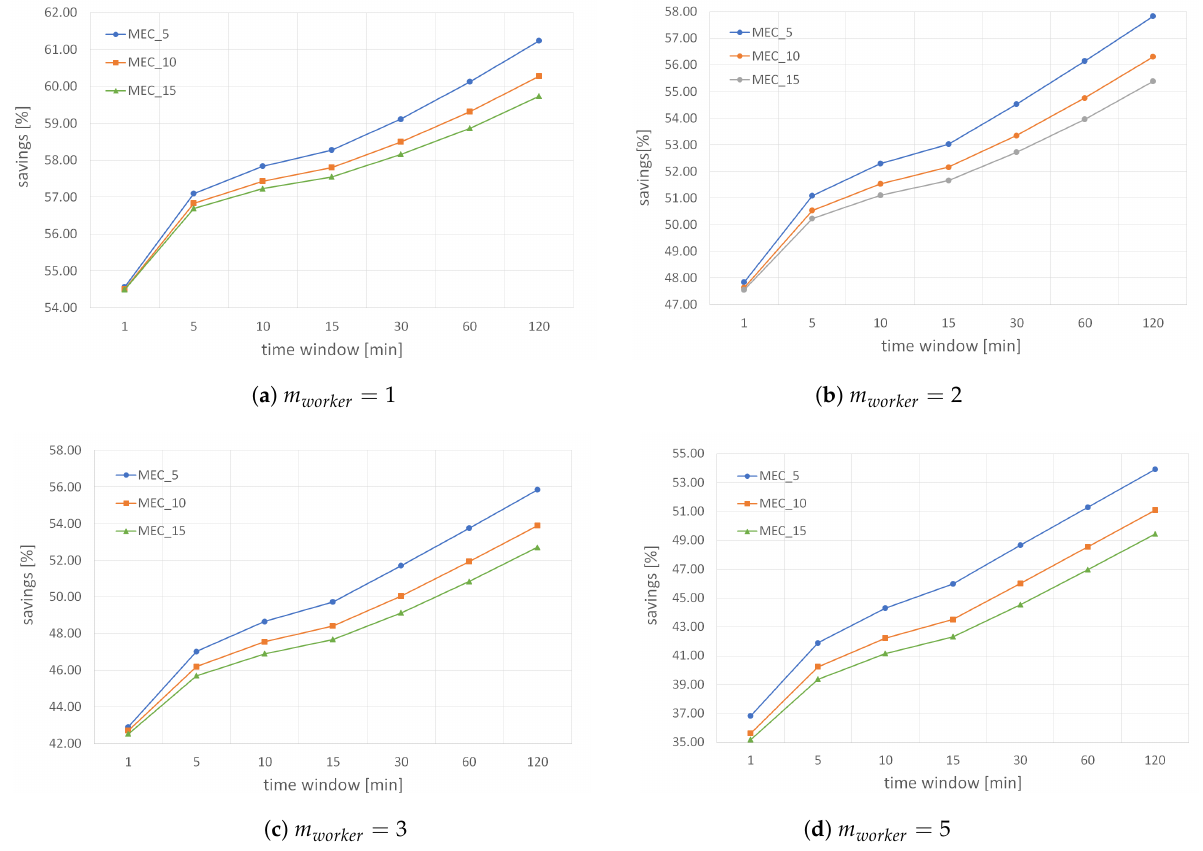
Figure 10. Energy savings with respect to the parameter m worker .